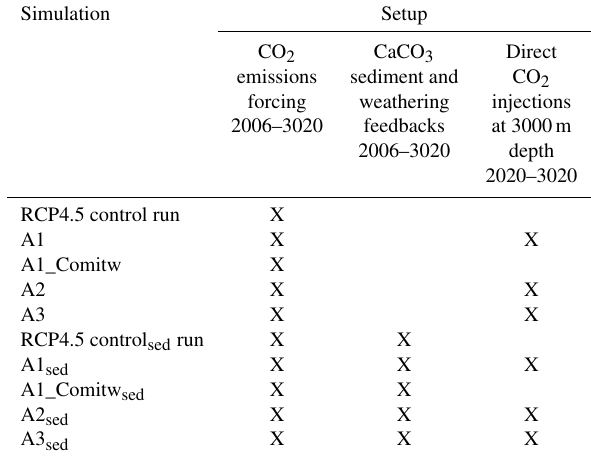
Table 1. Overview of all conducted simulations and their setup. The “X” denotes that the respective feature is applied. Note that the applied CO 2 forcing follows the RCP4.5 CO 2 emission sce- nario from 2006 to 2100 and the extended RCP4.5 CO 2 emissions scenario from 2100 to 2500. From 2500 onwards CO 2 emissions linearly decline until 0GtCyr − 1 in the year 3020. Simulation